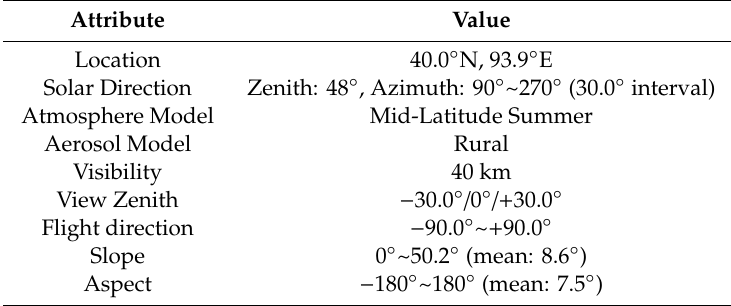
Figure 13. The reflected radiance of scene, ( a ) on flight direction 90 ◦ and view zenith − 30 ◦ ; ( b ) on flight direction 90 ◦ and view zenith − 30 ◦ . Table 4. Simulation Parameters for composite slope physical simulation experiment.